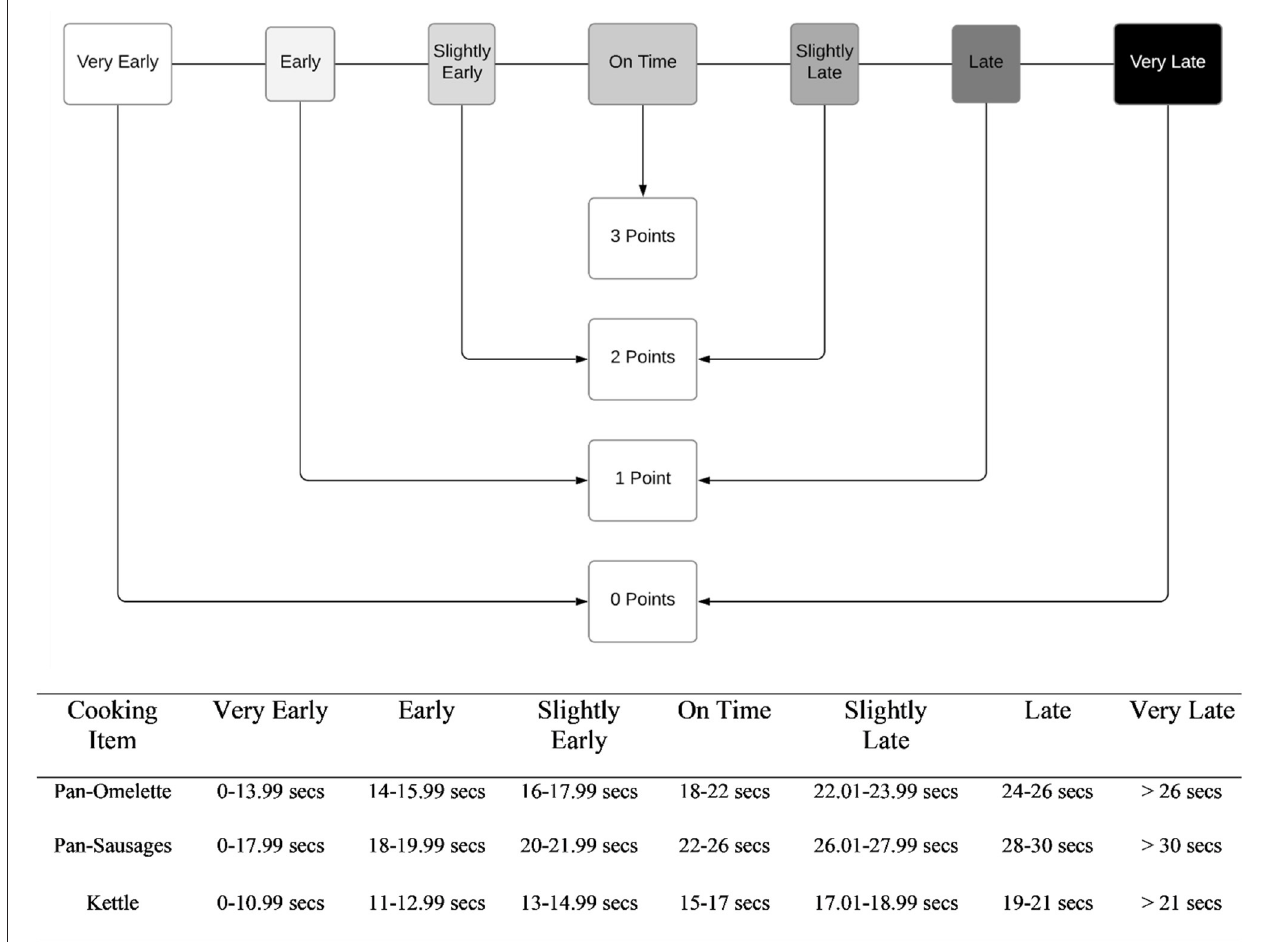
FIGURE 4 | A schematic representation of the cooking task scoring.